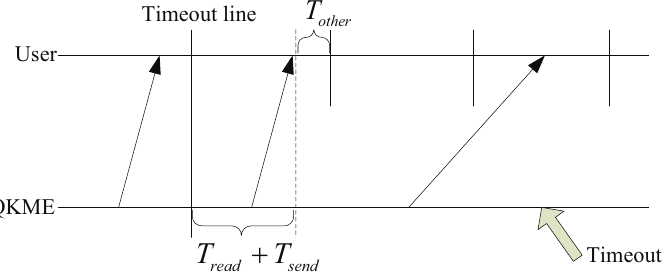
Figure 5. QKD real-time monitoring.